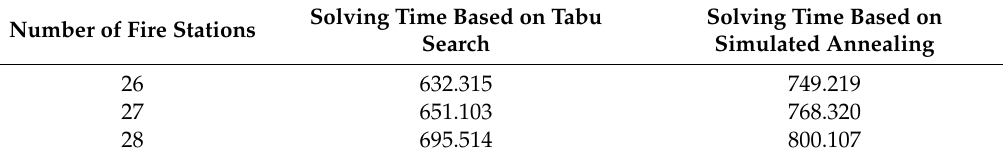
Table 13. Comparison of the average problem-solving time in